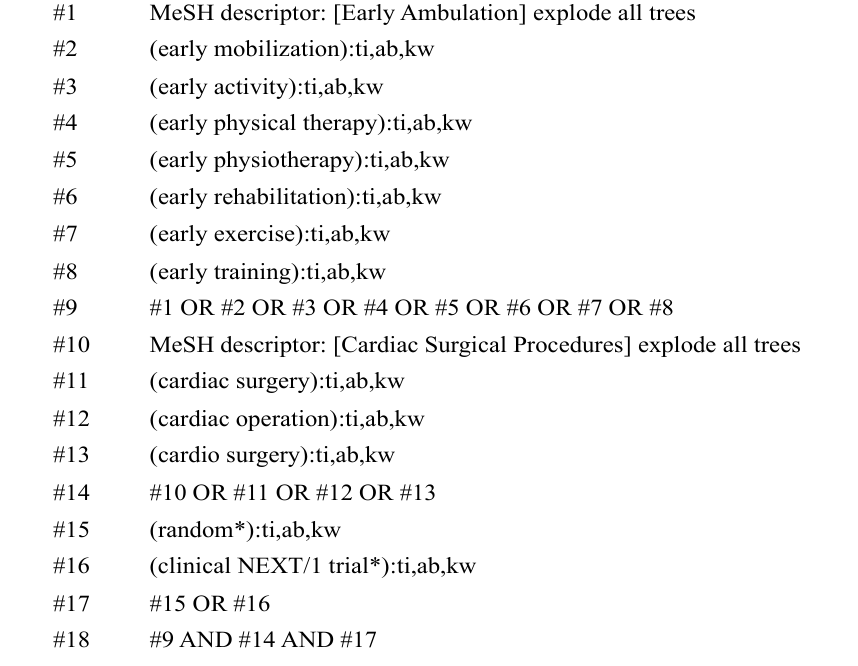
Figure 1. Search strategy in the present study. Legends: MeSH, medical subject headings; ti, title; ab, abstract; and kw, keyword.